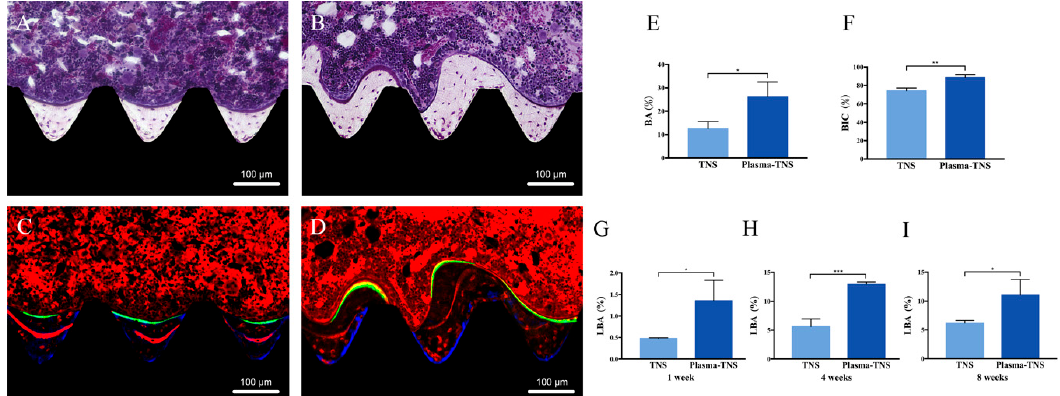
Figure 8. Villanueva staining of bone tissues around ( A ) TNS and ( B ) plasma-TNS implants. Fluorescence labeling of new bone and mineralization around ( C ) TNS and ( D ) plasma-TNS implants. ( E ) Bone area ratio (BA) and ( F ) bone-implant contact (BIC) of TNS and plasma-TNS implants. Fluorescently labeled bone area (LBA) after ( G ) one week, ( H ) four weeks, and ( I ) eight weeks. Data shown are the means ± SD ( n = 3). *** p < 0.001; ** p < 0.01; * p < 0.05.